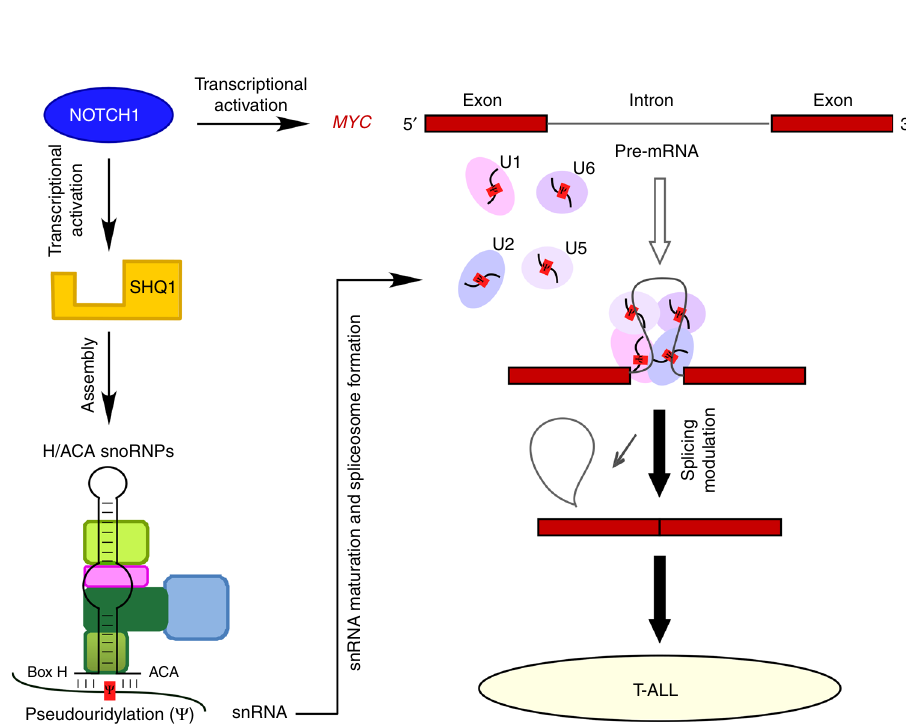
Fig. 8 Model depicting the NOTCH1 – SHQ1 – MYC axis in promoting T-cell leukemogenesis. NOTCH1 directly activates SHQ1 transcription. The resulting accumulation of SHQ1 protein optimizes the assembly of H/ACA snoRNPs and snRNA pseudouridylation, potentiating MYC pre-mRNA splicing. In addition to NOTCH1 transcriptional regulation of MYC , NOTCH1 induces SHQ1 expression and enhances MYC RNA processing, ultimately maximizing MYC expression in T-ALL. See discussion for more